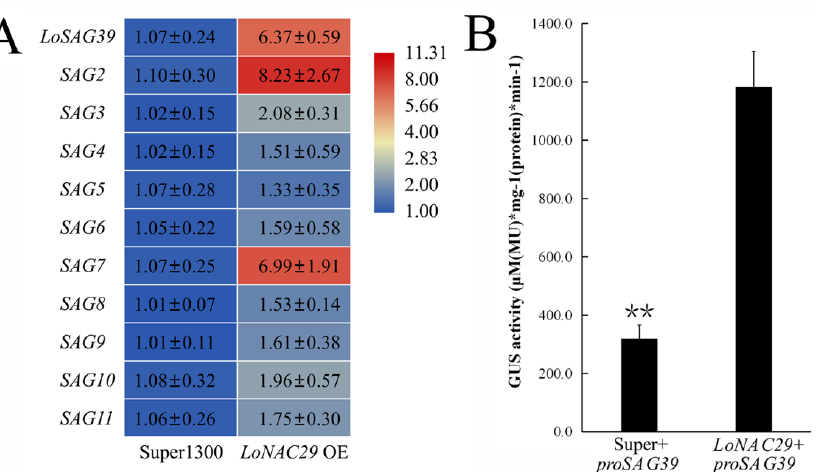
Figure 8. Regulation of senescence-associated genes ( SAGs ) by LoNAC29. ( A ) Expression of SAG genes in LoNAC29 OE and super vector control samples. The color indicates the expression level of genes, and the data represent the mean ± SE of three biological replicates. LoACTIN was used as the internal reference gene. ( B ) LoNAC29 regulates the promoter activity of LoSAG39 . The GUS reporter gene was used to indicate the promoter activity of LoSAG39 . The data represent the mean ± SE of three biological replicates. ** p < 0.01 (Student’ s t-test).